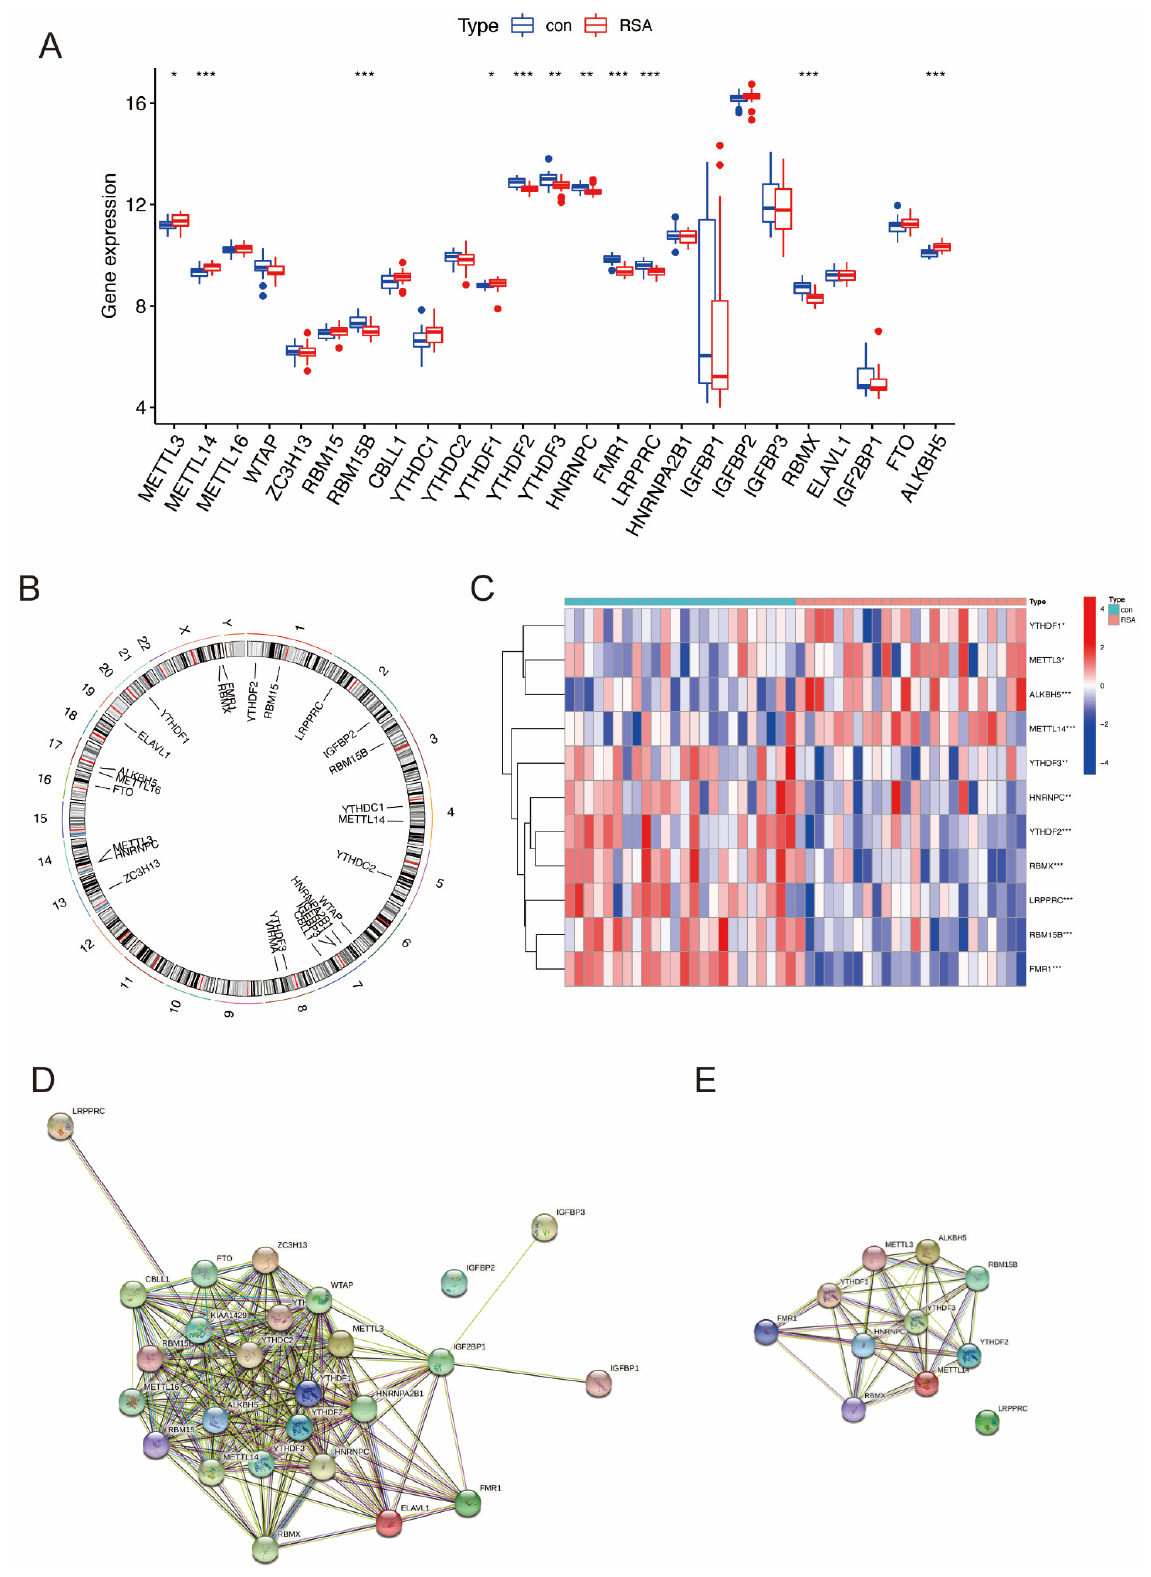
Figure 2. The landscape of the 25 m6A regulators in RSA. ( A ) Differential expression levels of the 25 m6A regulators between normal group and RSA patients. ( B ) Chromosomal positions of the 25 m6A regulators. ( C ) Expression heatmap of 11 significant m6A regulators. ( D ) PPI network of the 25 m6A regulators. ( E ) PPI network of the 11 significant genes. *: p < 0.05, **: p < 0.01, ***: p < 0.001.